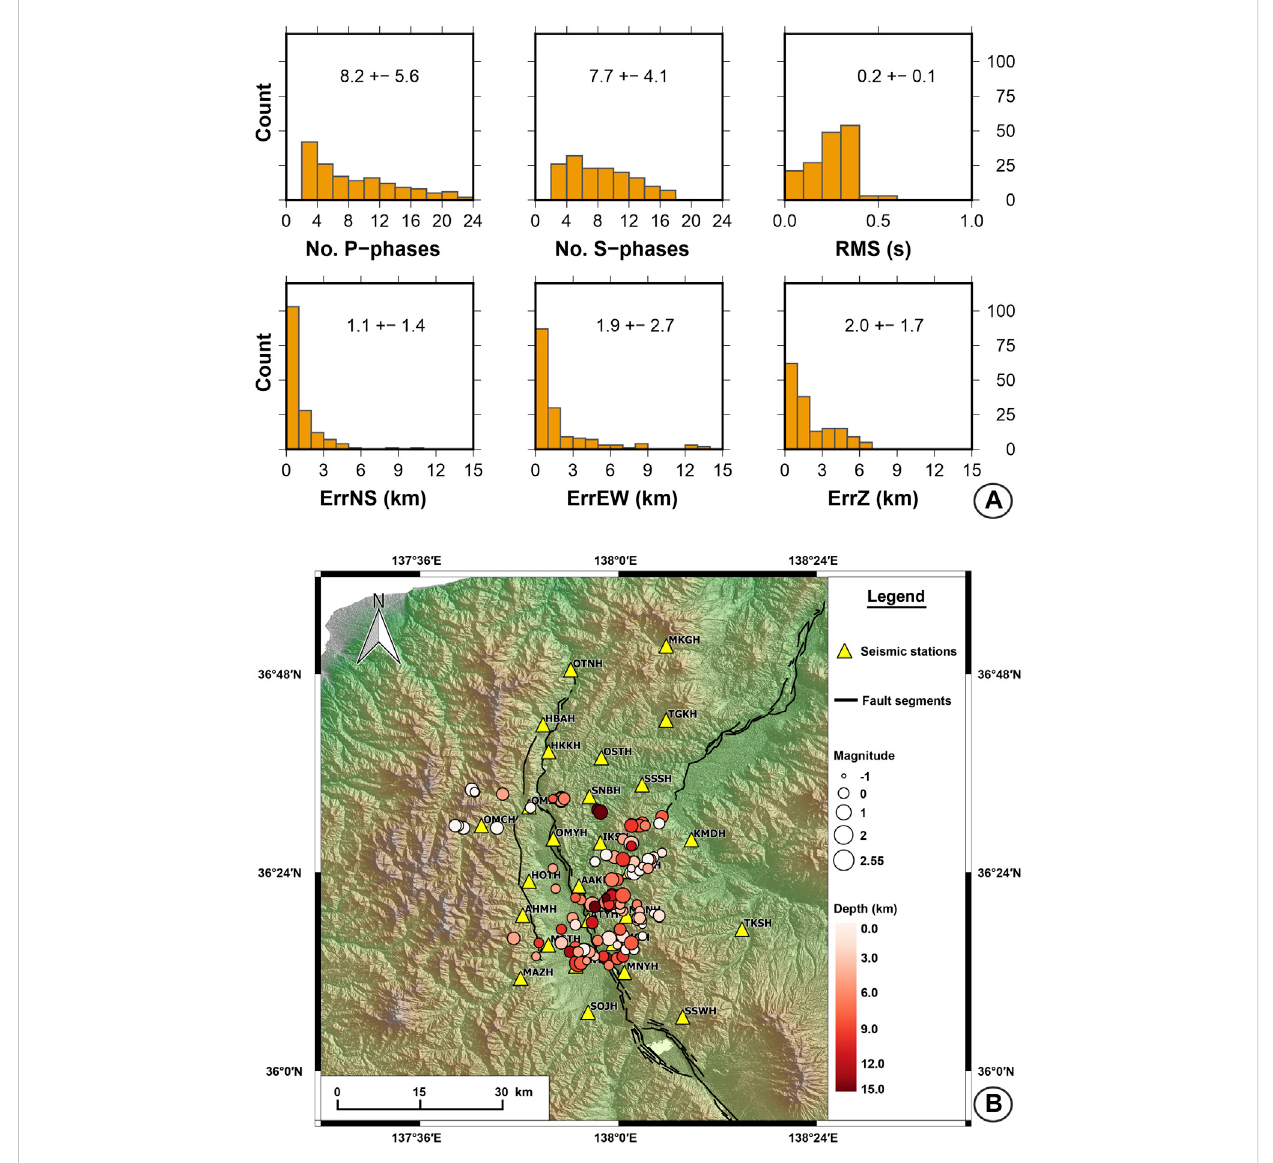
FIGURE 6 Results of TREMOR application to Nagano seismicity occurred during May 2011, in terms of location quality (A) and earthquake spatial distribution (B) . (A) Histograms for numbers of P- and S- readings, RMS of travel time residuals, and horizontal and vertical errors for the earthquake locations. For eachhistogram,themeanandstandarddeviationvaluesarereported. (B) Earthquakeepicenterslocatedbytheplatforminsidethetargetarea(redsquare in Figure 2B) for the Nagano region during the time period analyzed. Symbols and colors are the same as in Figure